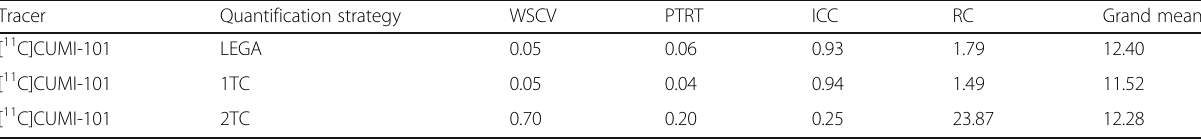
Table 2 Agreement indices for amygdala in the [ 11 C]CUMI-101 dataset for the three considered quantification approaches